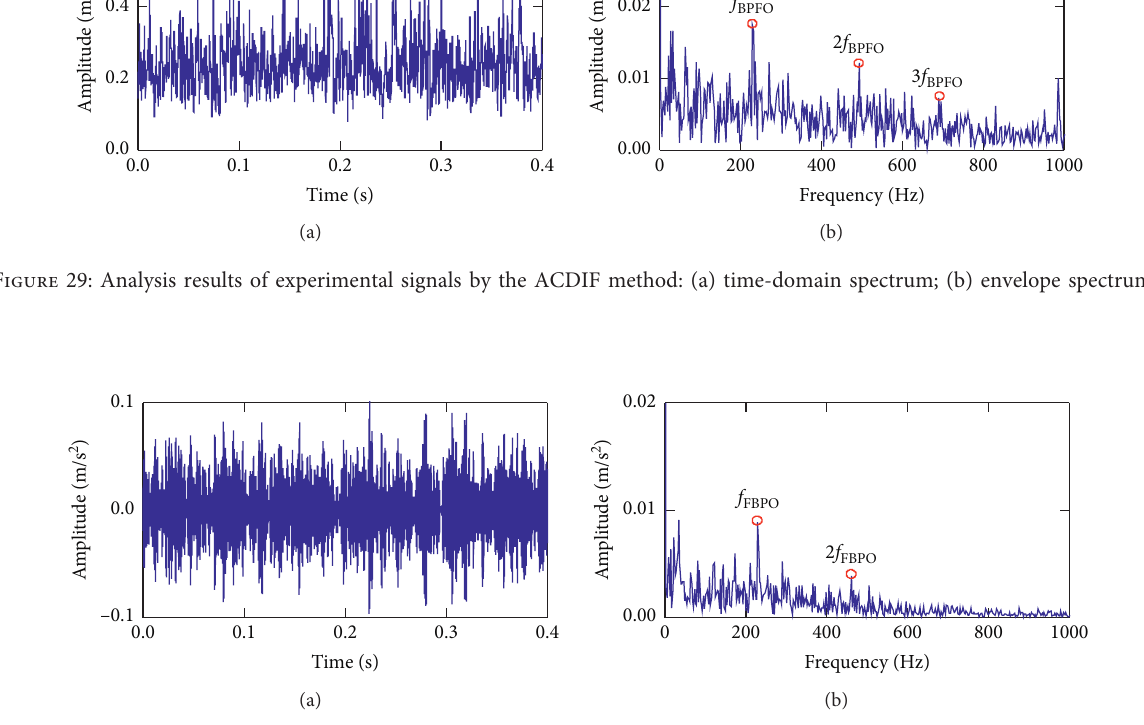
Figure 30: Analysis results of experimental signals by the VMD method with k � 5 and α � 2000: (a) time-domain spectrum of mode u4; (b) envelope spectrum of mode